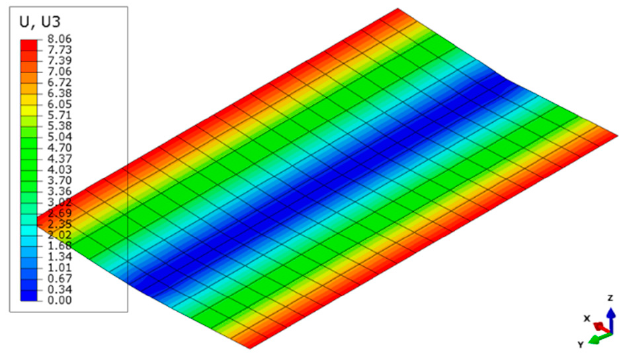
Figure 14. Angular distortion: proposed method (mm unit).